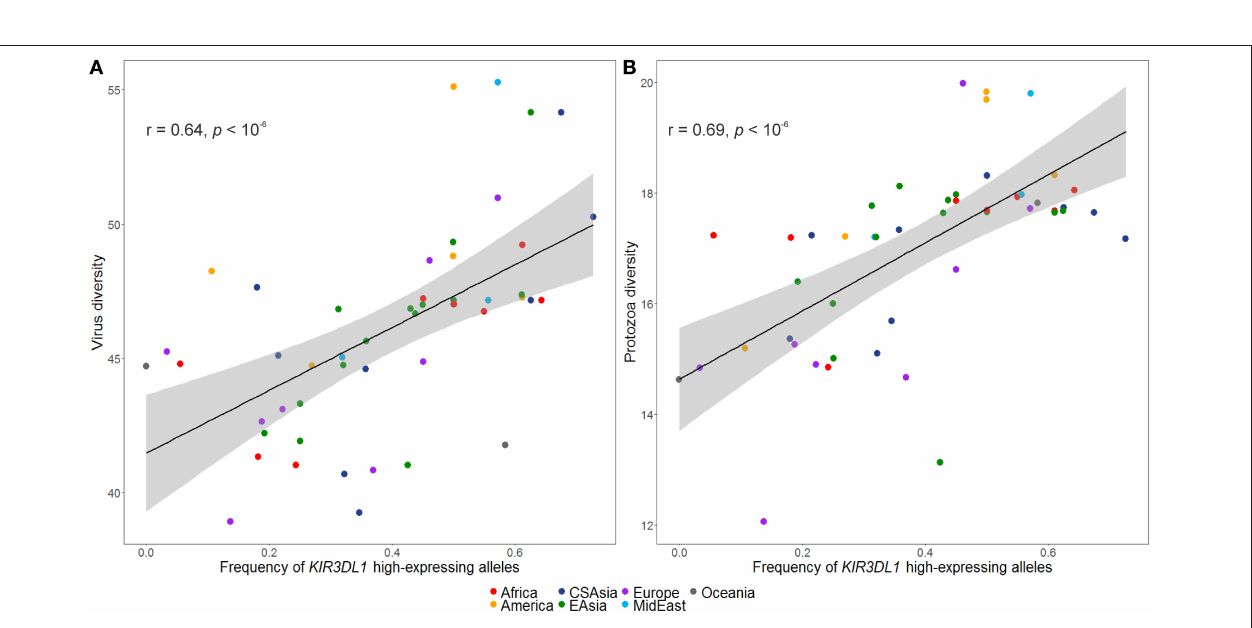
FIGURE 5 | Worldwide frequencies of KIR3DL1 high-expressing alleles correlate with virus and protozoa diversity. (A) Virus load correlates with frequencies of KIR3DL1 high-expressing alleles. (B) Protozoa load correlates with frequencies of KIR3DL1 high-expressing alleles. Each dot represents a population; the shaded area represents the 95% confidence interval for the regression